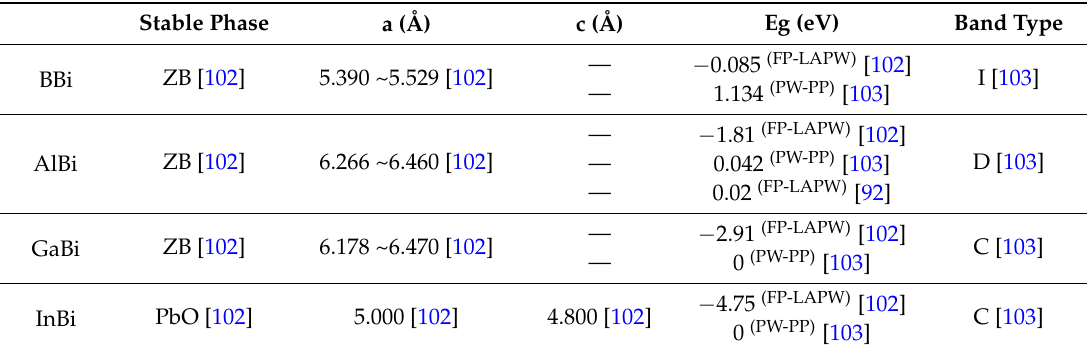
Table 3. Calculation results for structural and electronic parameters of III-Bi compounds. I = indirect band, D = direct band and C =